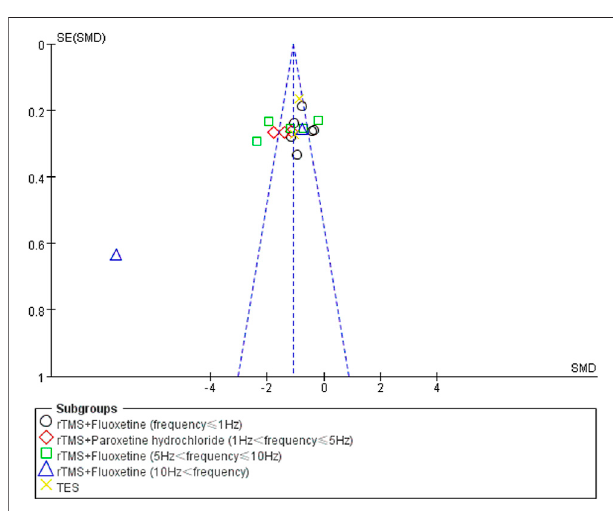
FIGURE 8 | Funnel plot of publication bias. SE, standard error; SMD, standard mean